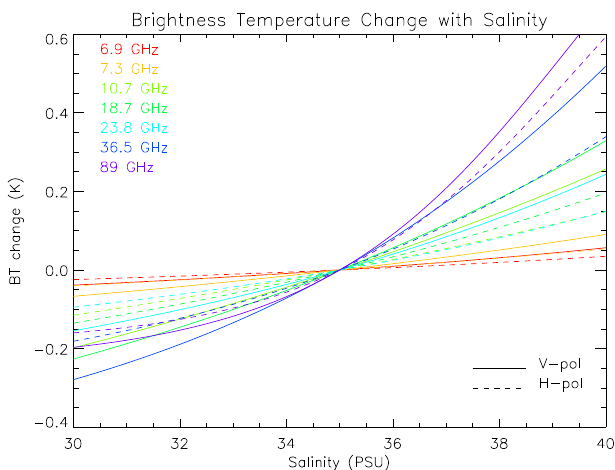
Figure 1. The change in the top-of-atmosphere brightness temperature from the value at 35 PSU as a function of salinity. The data were modelled by RTTOV for the AMSR2 instrument using the same atmospheric profile and with surface emissivities calculated by FASTEM. All channels are included ranging from 6.9 GHz (red) to 89 GHz (purple) with V-polarized channels indicated by solid lines and H-polarized channels by dashed lines.